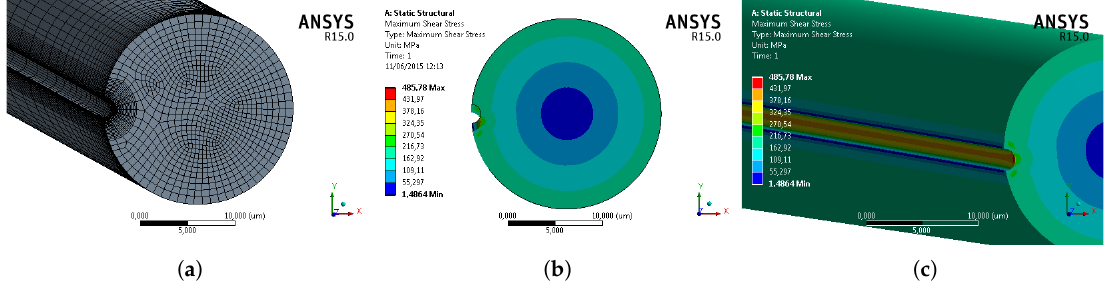
Figure 13. FEA applied to the case h = 10 r : ( a ) mesh; and ( b , c ) shear stress.